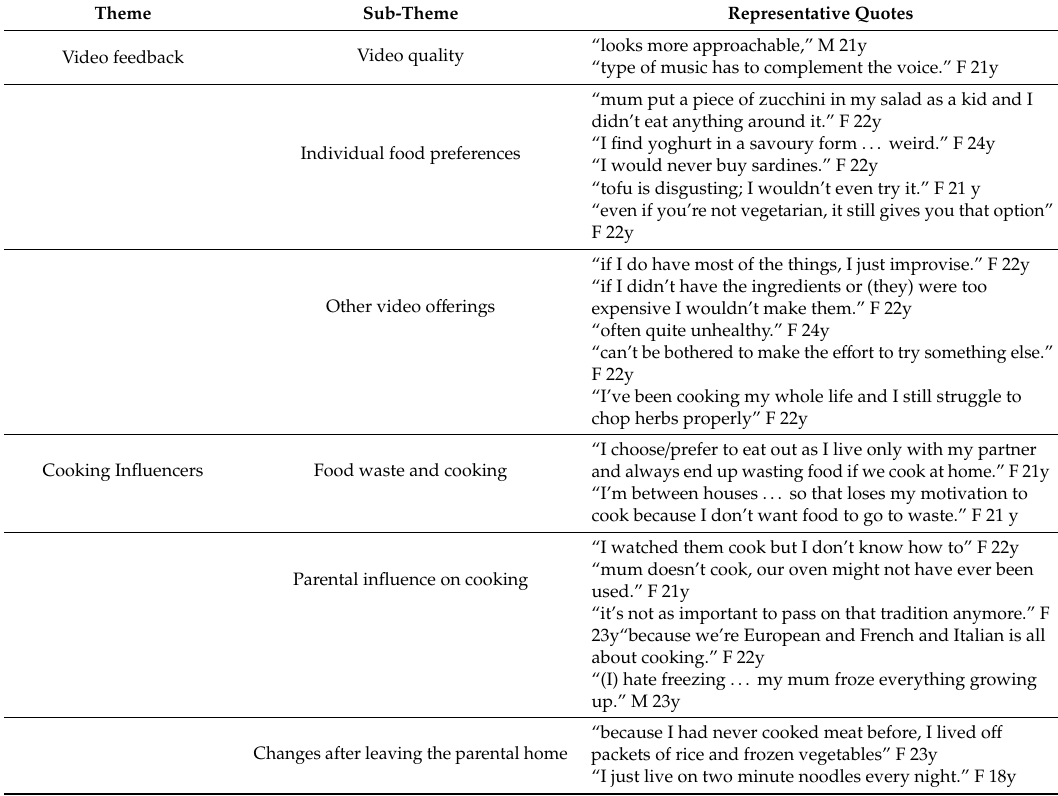
Table 3. Main Themes and Sub-themes from the Four Focus Groups with 34